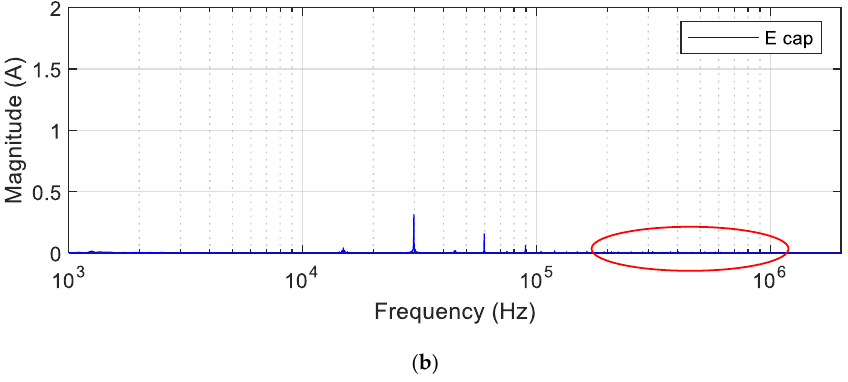
Figure 12. Magnitude of DC-link currents of VSI with electrolytic and film capacitors as functions of frequency. ( a ) electrolytic and ( b ) film capacitors as functions of frequency.